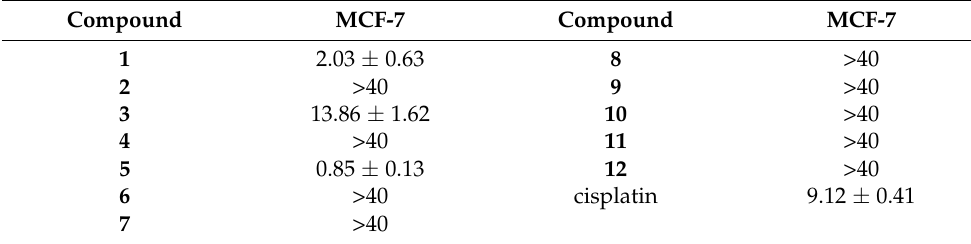
Table 4. The cytotoxic activities of isolated compounds (IC 50 , µ